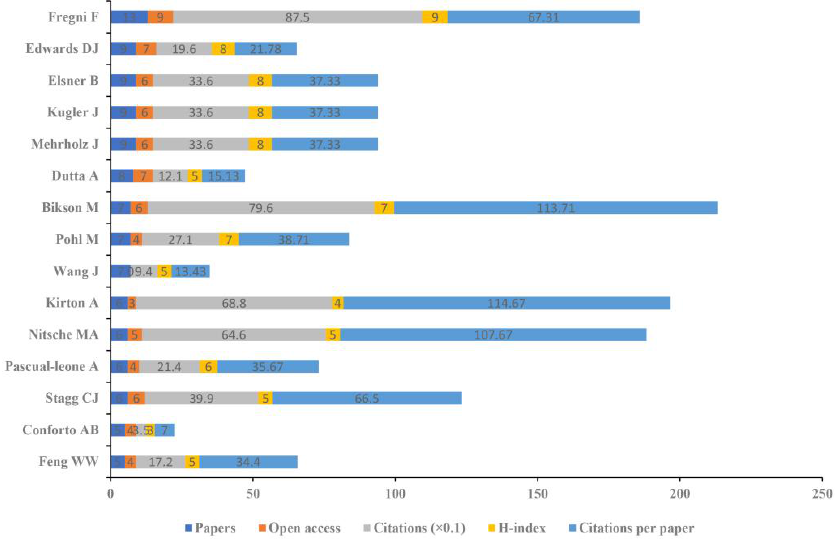
Figure 8. The amounts of papers, open access papers, citations, H-index, and citations per paper of the top 15 authors.